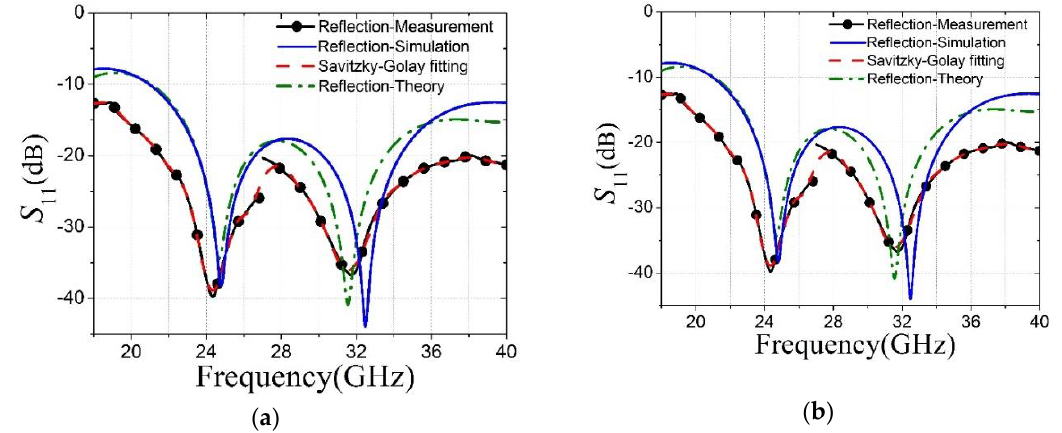
Table 4. EM (electromagnetic) properties of the constituent layers for 6-layer absorber.